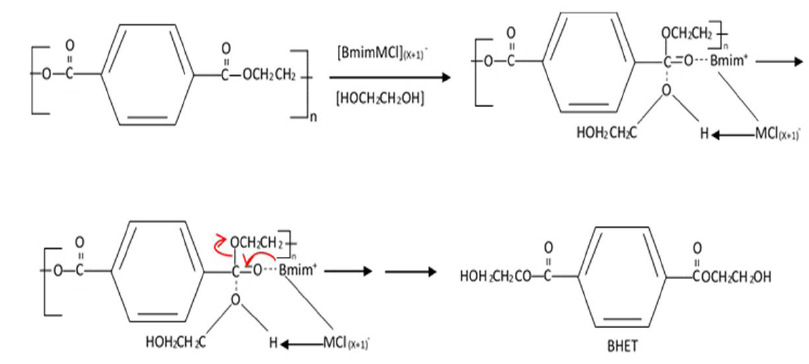
Figure 2. Possible mechanism scheme of the glycolysis reaction of PET in the presence of metal-containing ionic